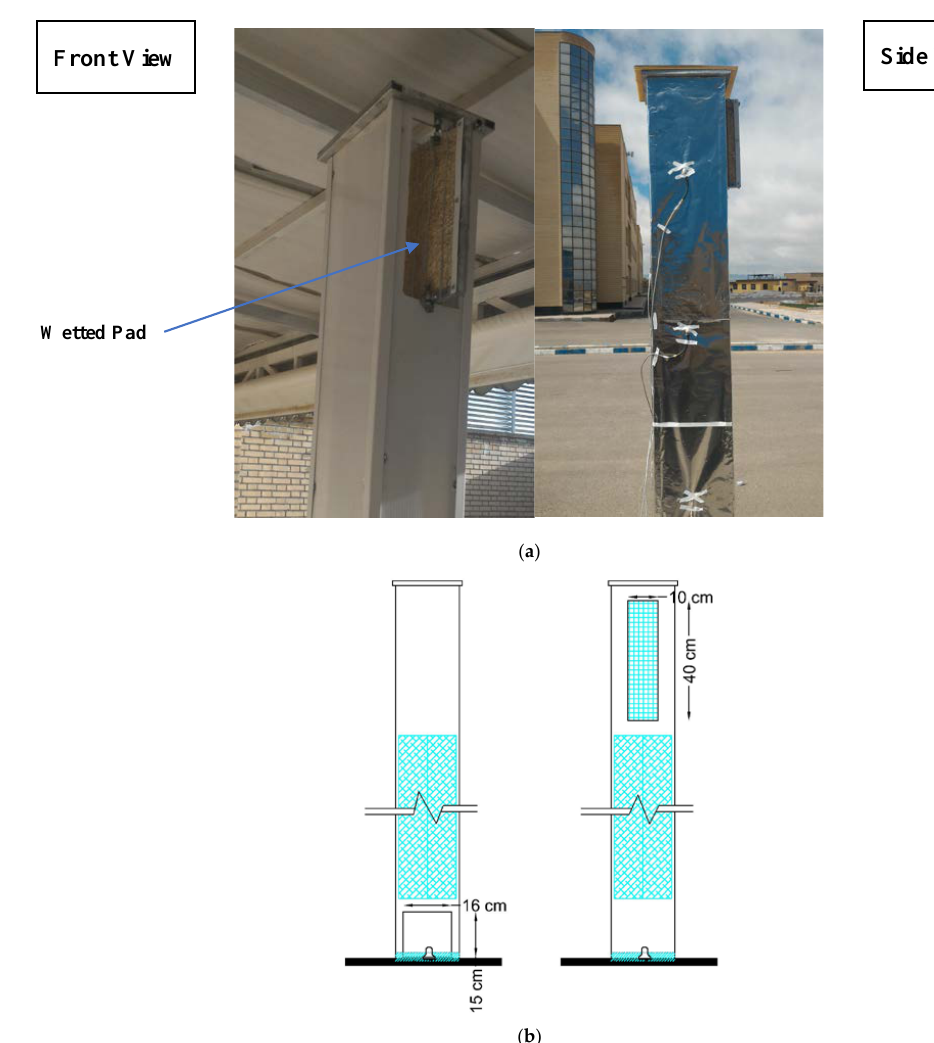
Figure 2. ( a ) The photograph of the designed wind catcher, ( b ) The dimensions of the wind catcher.